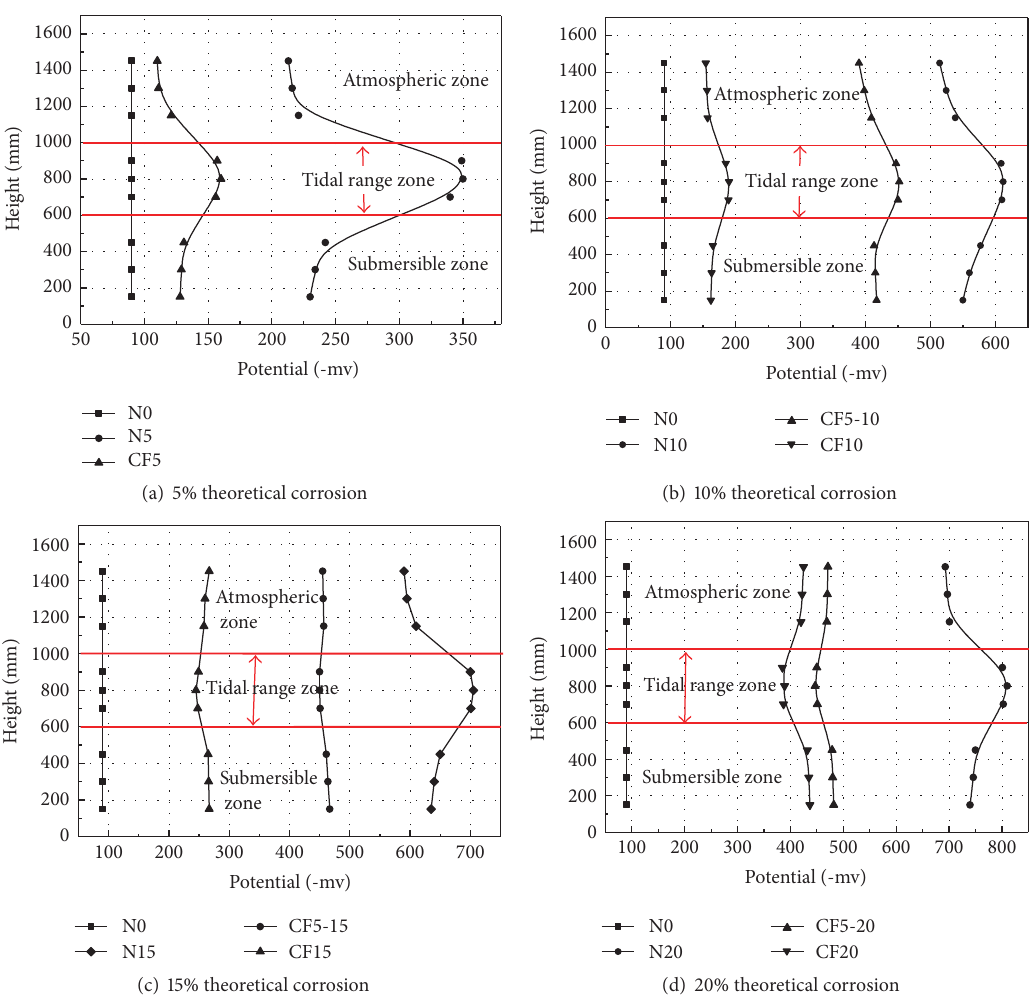
Figure 6: Measured half-cell potentials of